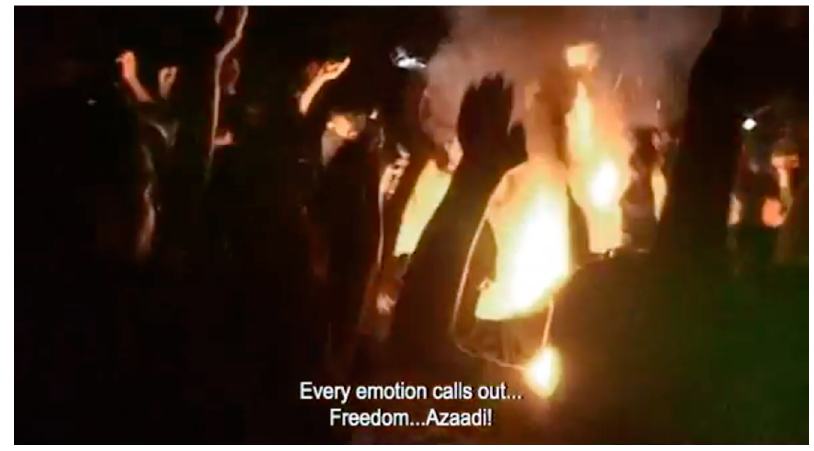
Figure 2. Khoon Diy Baarav (2015), sequence of a rag ḍ a, by courtesy of Iffat Fatima.